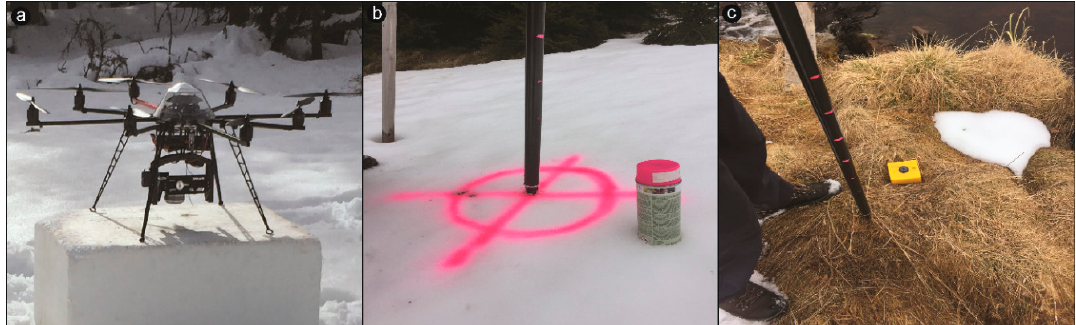
Figure 2. ( a ) Applied ARF MicroKopter Okto XL equipped with RGB Lumix-GX7 camera (Panasonic Corporation, Osaka, Japan); ( b ) Marked ground control points (GCPs) and checkpoints (CPs) with visible pink spray during all winter campaigns; ( c ) Yellow geodetic pits and white papers served as GCPs during the snow-free campaigns.